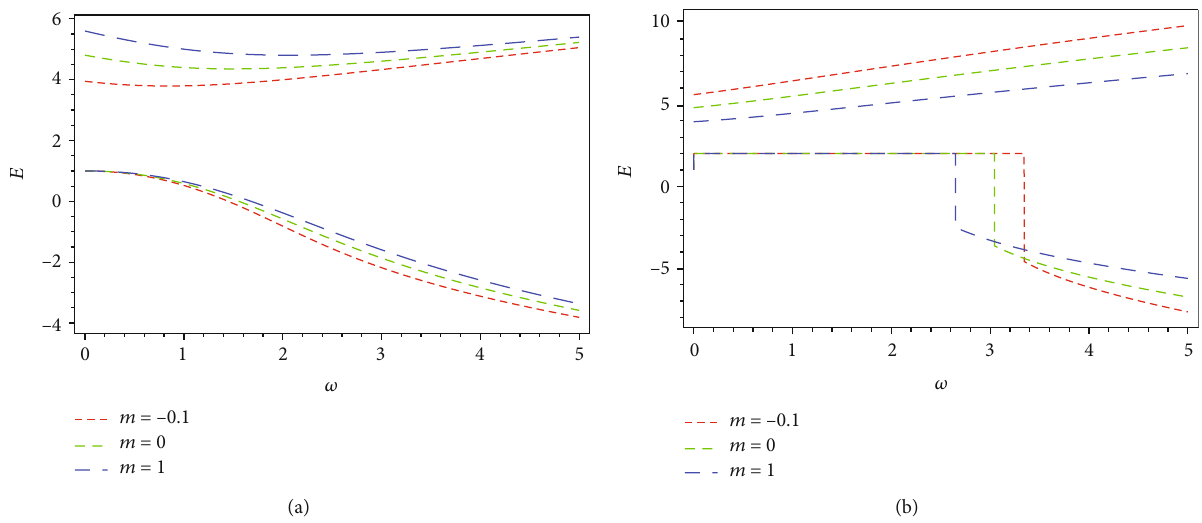
Figure 2: Illustration of the energy eigenvalues in the pseudospin symmetry limit (Eq. (35)) as a function of the parameter ω for (a) s = 1 and (b) s = − 1 . We use units such as M = 1 , n = 1 , a = 1 and an upper bound ε = 10 − 7 .